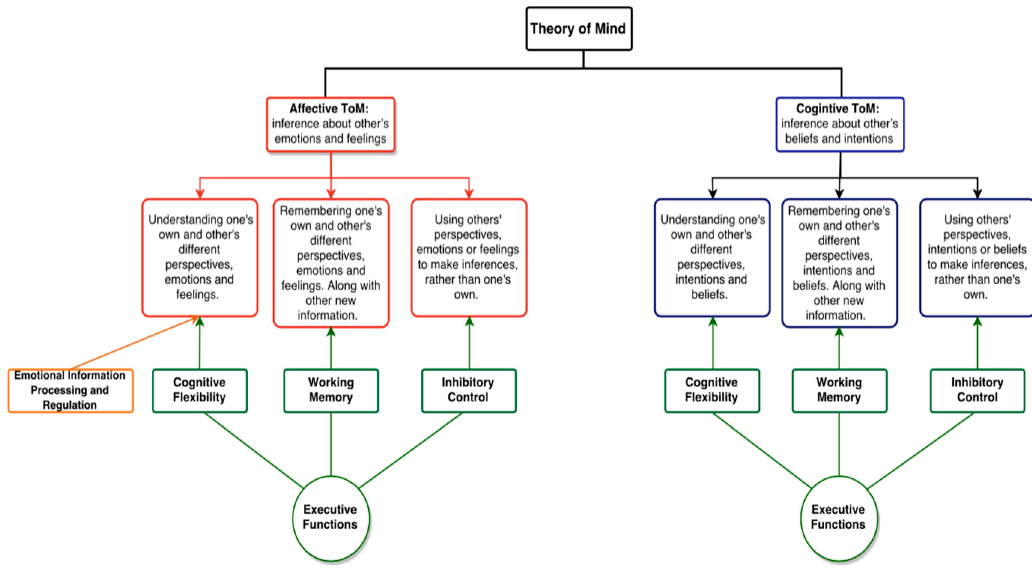
Figure 1. Flowchart demonstrating links between Theory of Mind (ToM) and executive functions (EF). Theory of mind is split into cognitive ToM, the ability to understand and make inferences about others’ beliefs and intentions; and affective ToM, the ability to understand and make inference about others’ emotions and feelings. Presented are the links found in literature [64, 67, 70] between affective and cognitive ToM in youth, with three EF subtypes: (1) cognitive flexibility; (2) working memory; and (3) inhibitory control. In addition to associations with EF, affective ToM is also associated with emotional information processing and regulation, needed to understand various feelings and emotions of others and oneself.